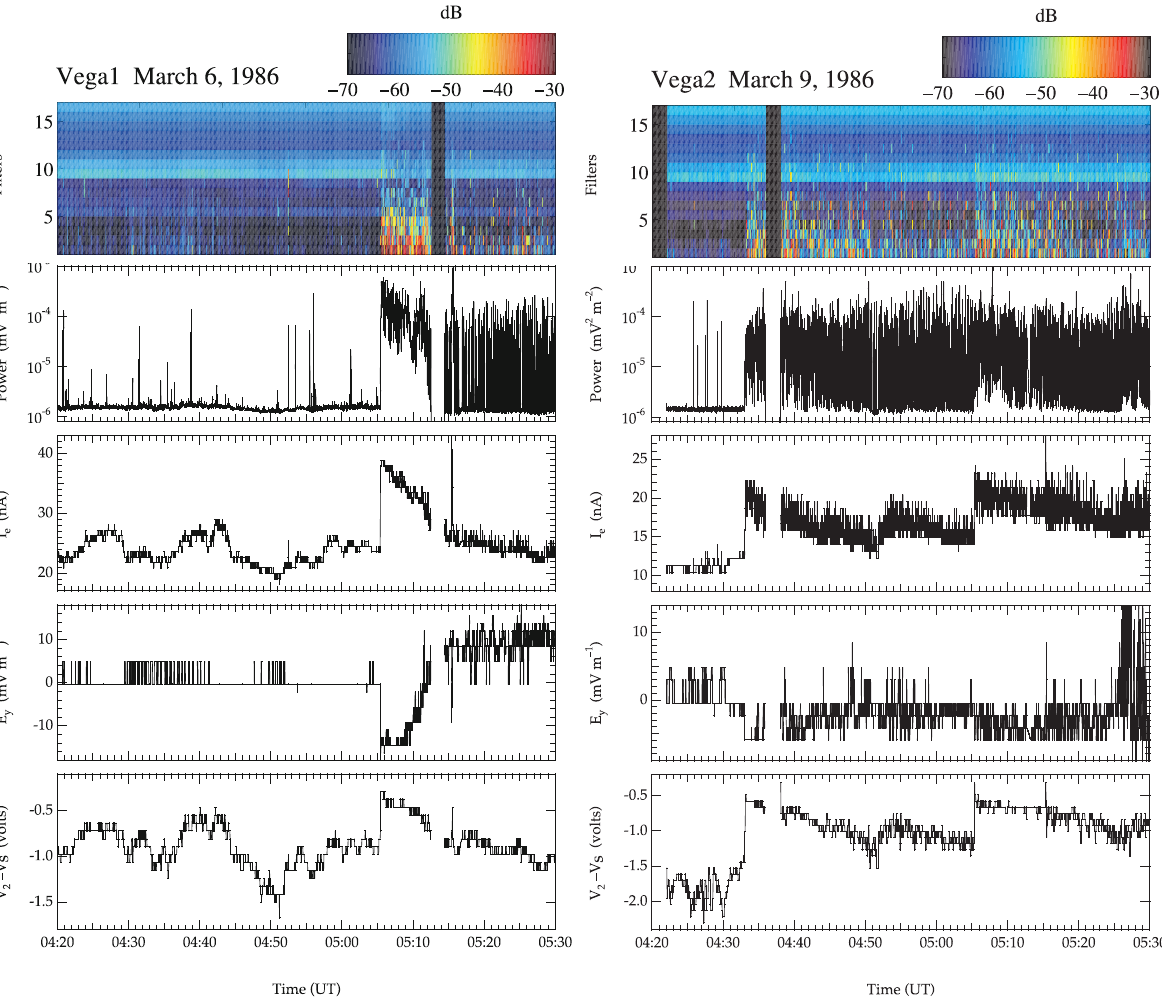
Fig. 4. Summary plots of the plasma and wave disturbances observed during the gas releases on (a) Vega 1 and (b) Vega 2 (see text for